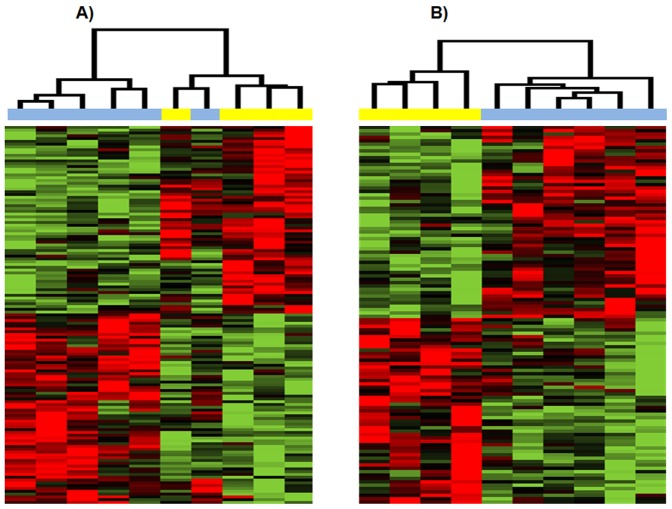
Hierarchical clustering of patient samples based on differentially
expressed genes (P<0.01) obtained from comparing good prognosis
versus poor prognosis in the USC group and EAC group,
respectively.
A) USC group. B) EAC group. In
clustering dendrogram, blue stands for good prognosis samples while
yellow stands for poor prognosis samples. Red means up-regulated while
green means down regulated.